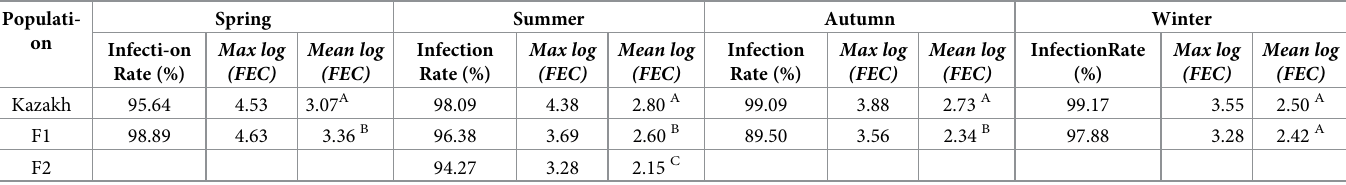
Kazakh and F1 generation sheep showed no differences in GIN infection rate or mean log (FEC) ( P > 0.05, Table 5). Coccidia infection in different sheep populations in various seasons. The rate of coc- cidia infection among the Kazakh sheep was higher than that of the F1 generation in summer, autumn, and winter. In spring, the rate of coccidia infection was slightly higher in the F1 gen- eration compared to the Kazakh sheep. In summer, the rate of coccidia infection in the F2 gen- eration was higher than that observed in the F1 generation and the Kazakh sheep (Table 6). The mean log (FOC) of oocysts among the Kazakh sheep was extremely high compared to that of the F1 and F2 generations in spring, summer and autumn ( P < 0.01). Moreover, the F2 gen- eration displayed an evidently larger value compared to the F1 generation in summer ( P < 0.01). In winter, there was no significant difference in the mean log (FOC) of oocysts between the Kazakh sheep and the F1 generation ( P > 0.05, Table 6). Correlation analysis of GIN and coccidia infections in different sheep populations. The FEC elevated with increase in the severity of Eimeria coccidia infection in general. The infec- tion intensity of coccidia had a highly significant effect on the infection intensity of nematodes ( P < 0.001, Fig 4-1), exhibiting a positive correlation coefficient of 0.187 ( P < 0.001). The infec- tion intensity of coccidia in Kazakh sheep demonstrated a highly significant effect on the infection intensity of nematodes ( P < 0.001, Fig 4-2), with a positive correlation coefficient of 0.124 ( P < 0.001). The infection intensity of coccidia in the F1 generation also displayed a highly signifi- cant effect on the nematode infection intensity ( P < 0.001, Fig 4-3) with a positive correlation coefficient of 0.223 ( P < 0.001). However, there was no correlation (value = -0.035) between the infection intensity of coccidia and nematode in the F2 generation ( P > 0.05, Fig 4-4). Identification GIN species in sheep GIN egg identification. On the basis of the morphological characteristics of eggs and referral to “Veterinary Parasitology” (Second Edition) [33] and “Veterinary Clinical Parasitol- ogy” (Eighth Edition) [34], a total of nine species of gastrointestinal nematodes were initially identified (Fig 5). Table 6. Coccidia infection rate (%) and log(FOC) of different sheep populations for various seasons. Populati- Spring Summer Autumn Winter on Infecti-on Max log Mean log Rate (%) (FOC) (FOC) Kazakh F1